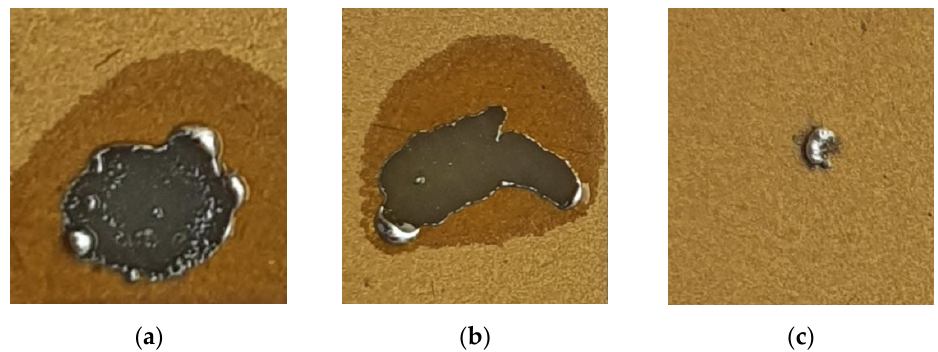
Figure 2. Results of solder melting process: ( a , b ) the simultaneous use of In solder and flux; ( c ) the use of In solder without flux.